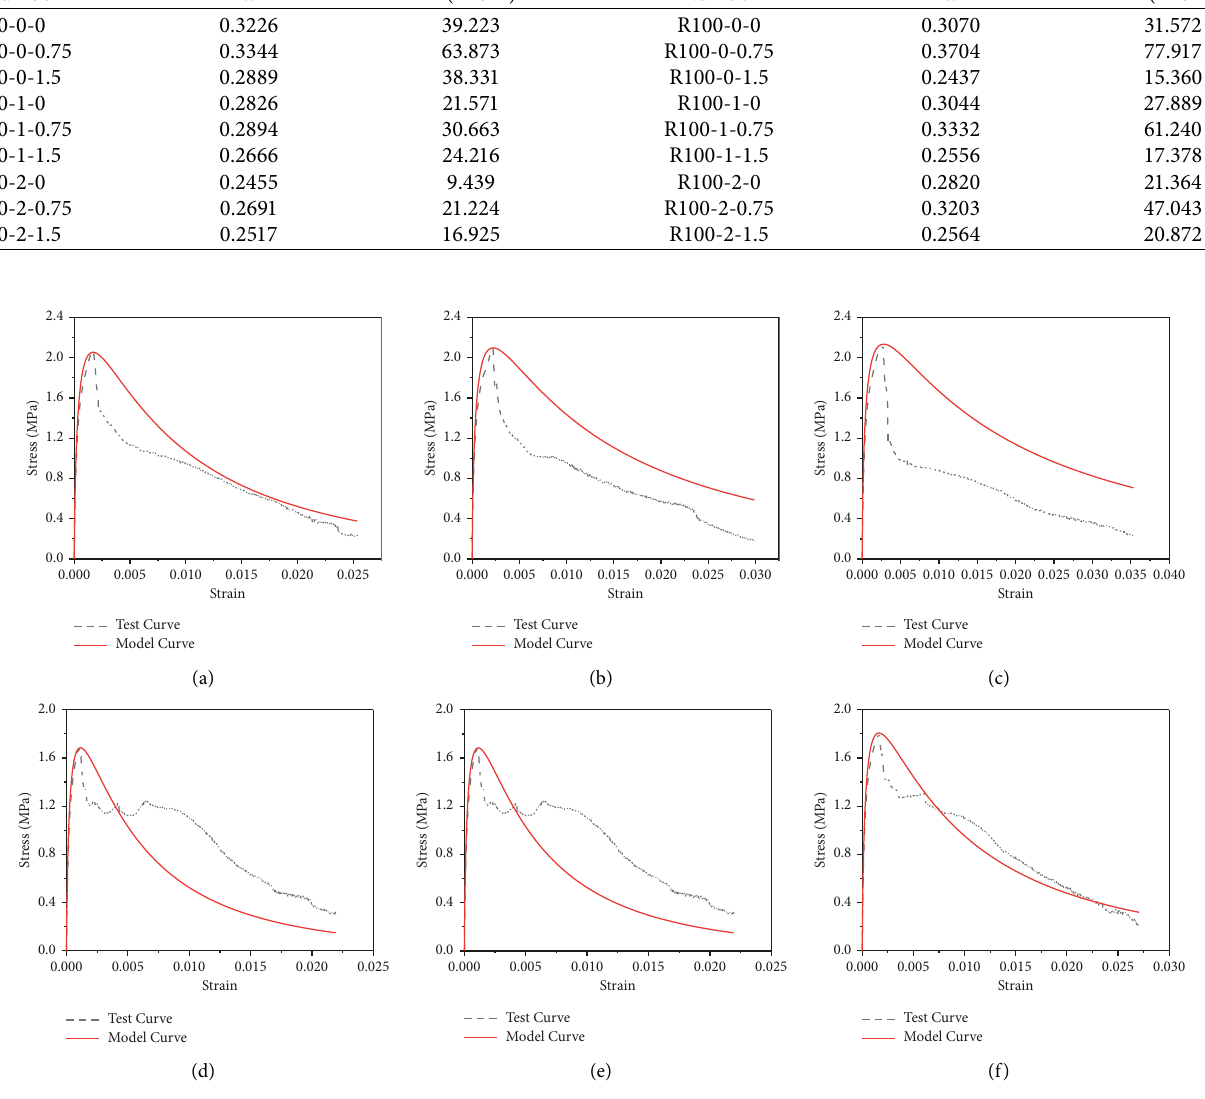
Figure 12: The stress-strain curves. (a) R0-0-0.75. (b) R0-1-0.75. (c) R0-2-0.75. (d) R100-0-0.75. (e) R100-1-0.75. (f)